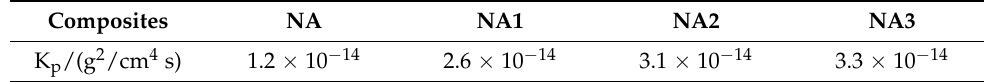
Table 2. Parabolic constants of all composites.